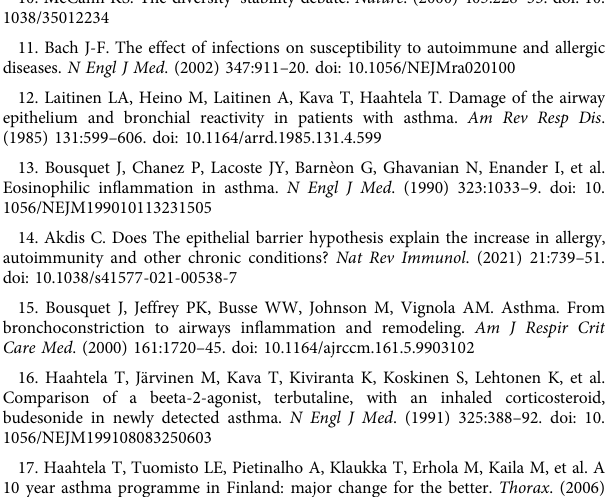
Figure 5 : from global war destruction to great acceleration , population explosion, urbanization, and overuse of natural resources to great slowdown . The COVID-19 pandemic showed the priorities of the societies: health and safety come fi rst. For a more sustainable future, integrated prevention of human disease, climate crisis, and nature loss with the new technical and scienti fi c innovations makes sense (112, 113). Management of the environmentally-driven allergic and respiratory disease may demonstrate the transition and pave the way guided by the Helsinki Alert 2015 (114) and Declaration 2020